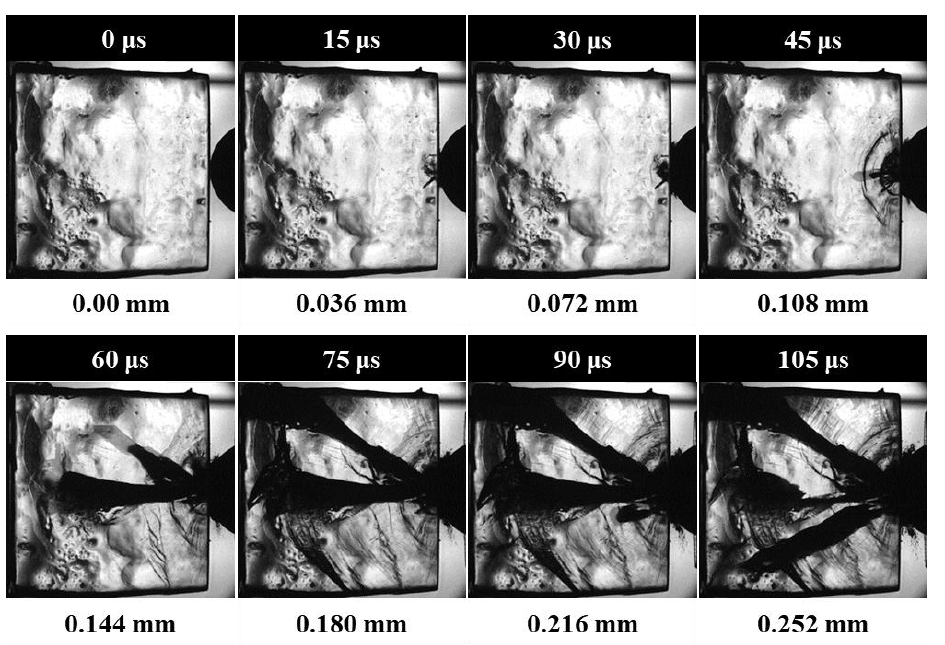
Fig. 3. Process of ice fracturing obtained by the high-speed camera. The top of each image shows the time since the ice surface and indenter tip came into contact, and the bottom shows the displacement at that